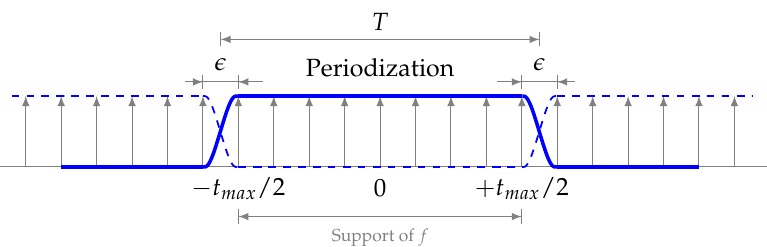
Figure A3. Periodization of a tempered distribution.